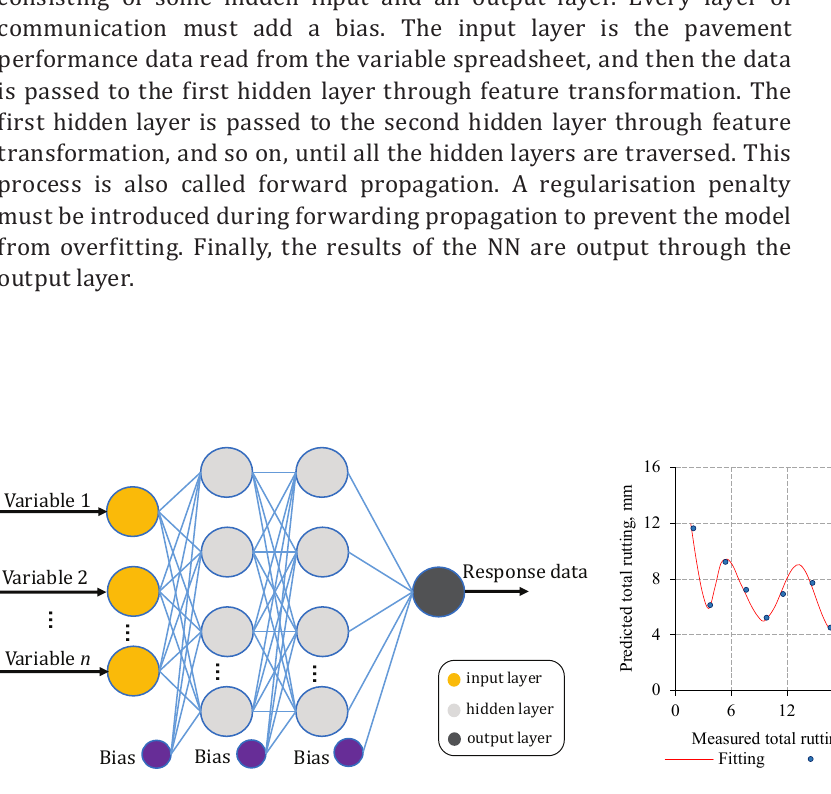
Figure 2. Baseline network architecture Figure 3. Model